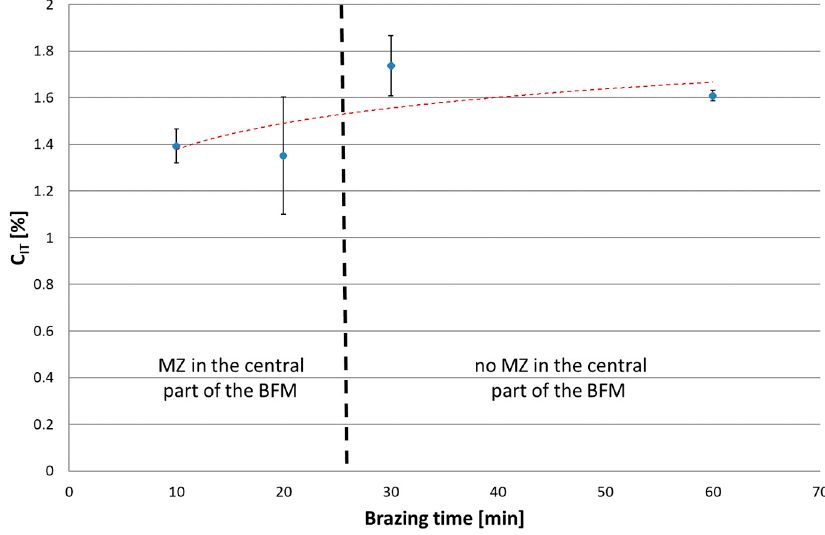
Figure 19. Indentation creep for Hastelloy X–Palnicro 36M joints by 1 N load.